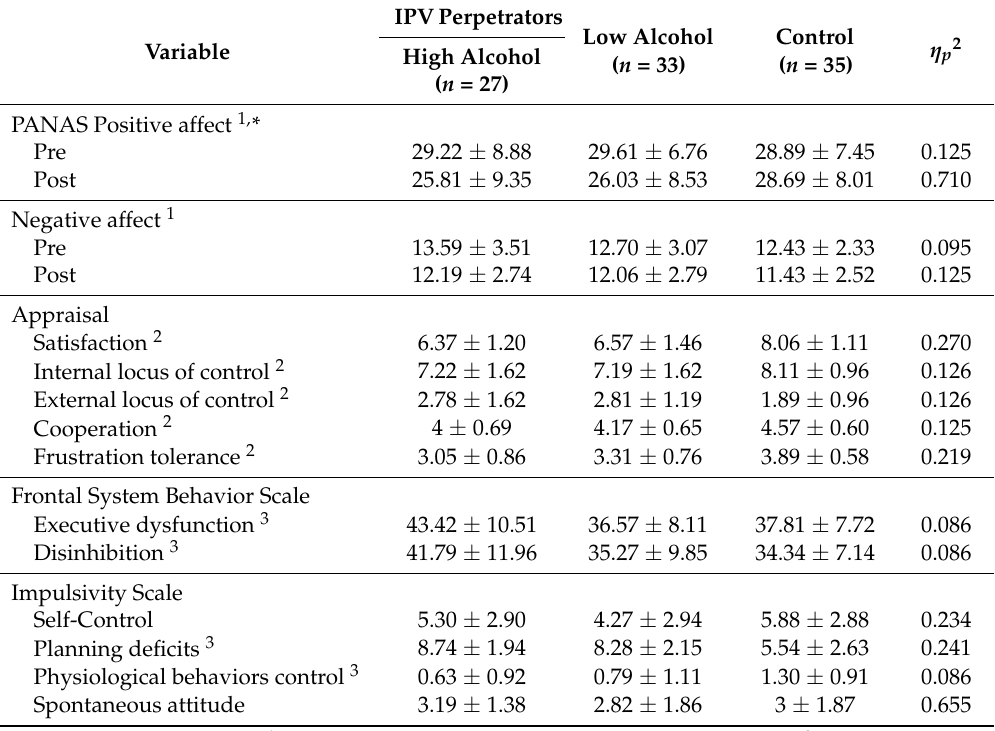
Table 2. Mean ± SD of psychological measures for all groups (* p <